Question: How would you classify this visualization?
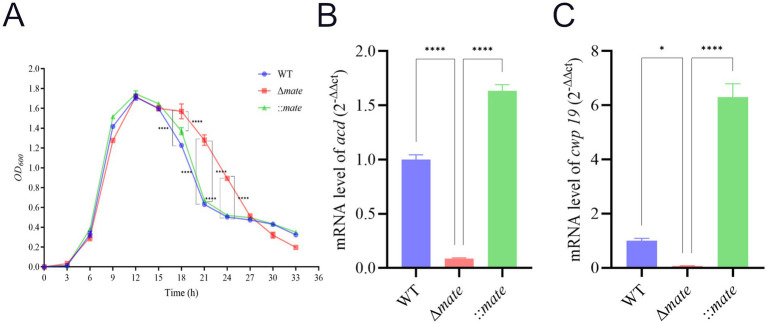
Answer: line